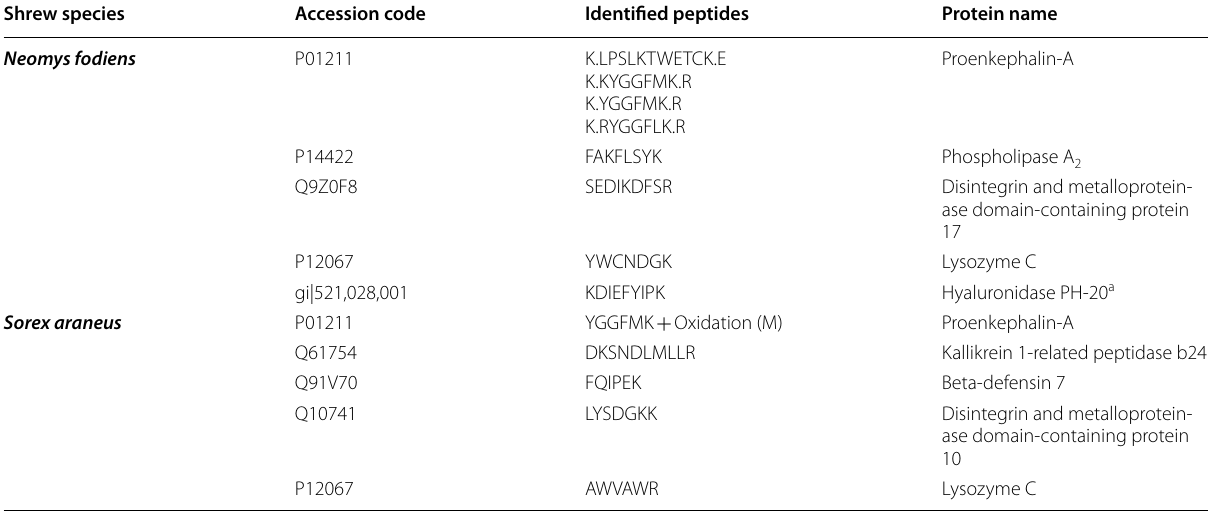
a hyaluronidase does not display toxic activity but is a toxin spreading factor commonly found in animal venoms